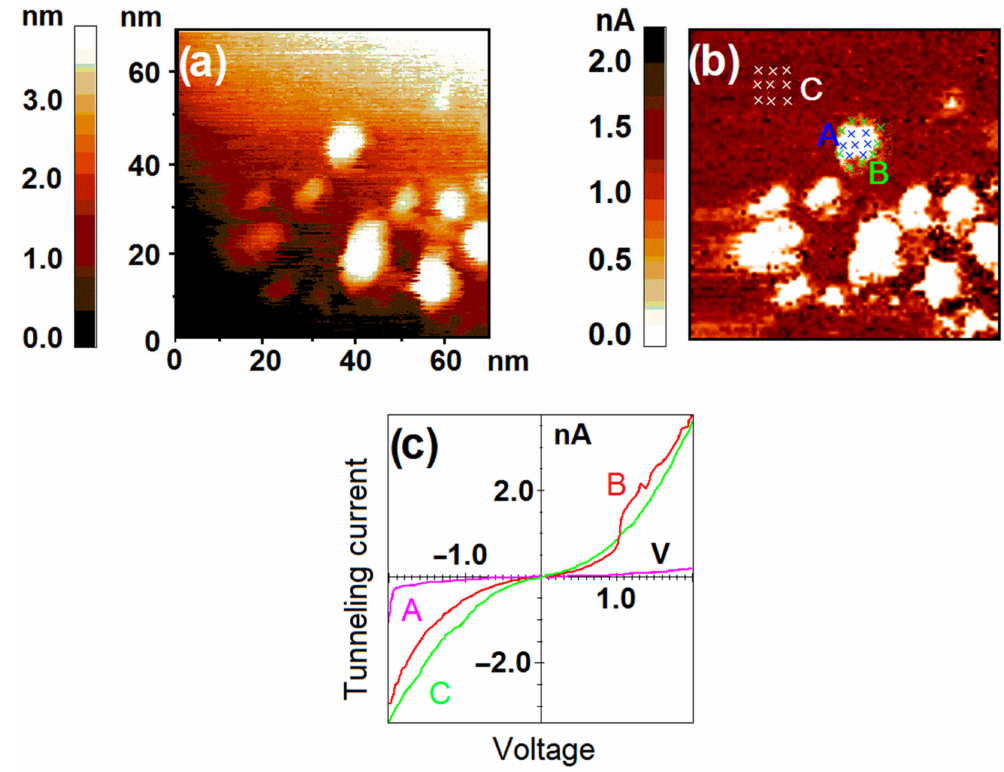
Figure 3. The sample after exposure to O 2 (50 L). Results of the STM/STS measurement: ( a ) topogra- phy image of the HOPG surface with deposited nickel nanoparticles; ( b ) distribution of tunneling current values at 1.2 V over the same area with points of spectroscopy measurements marked with crosses; ( c ) VAC curves of the tunneling currents averaged over the set of points on the surface of HOPG (green curve C), central (pink curve A) and perimeter (red curve B) areas of the nanoparticle marked in ( b